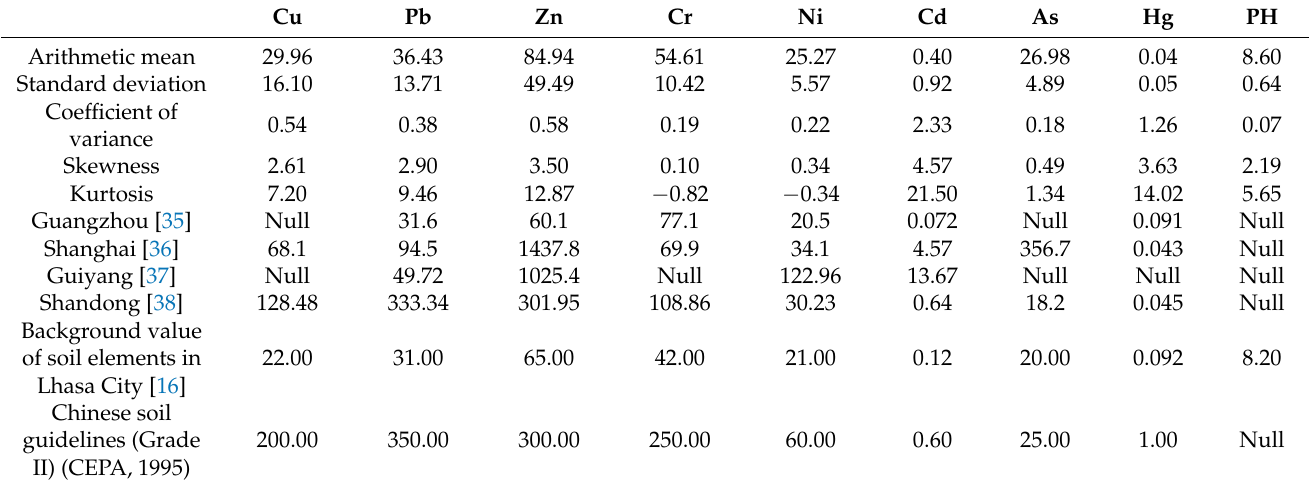
Table 1. Summary statistics of heavy metal concentrations (mg/kg) in the landfill